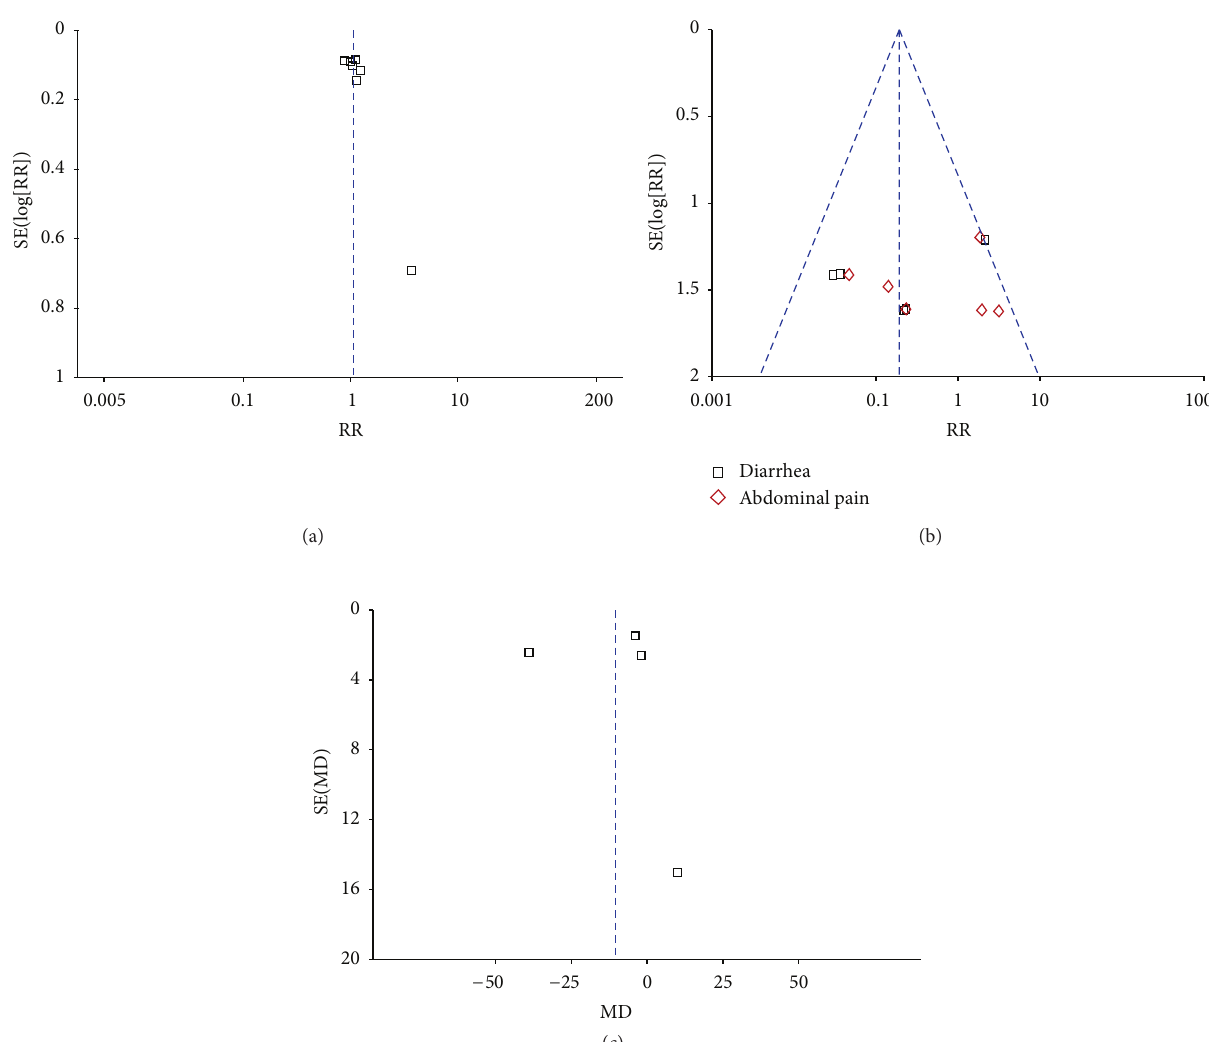
Figure 5: Funnel plot of meta-analysis. (a): effectiveness, (b): adeverse events and (c): blood ammonia